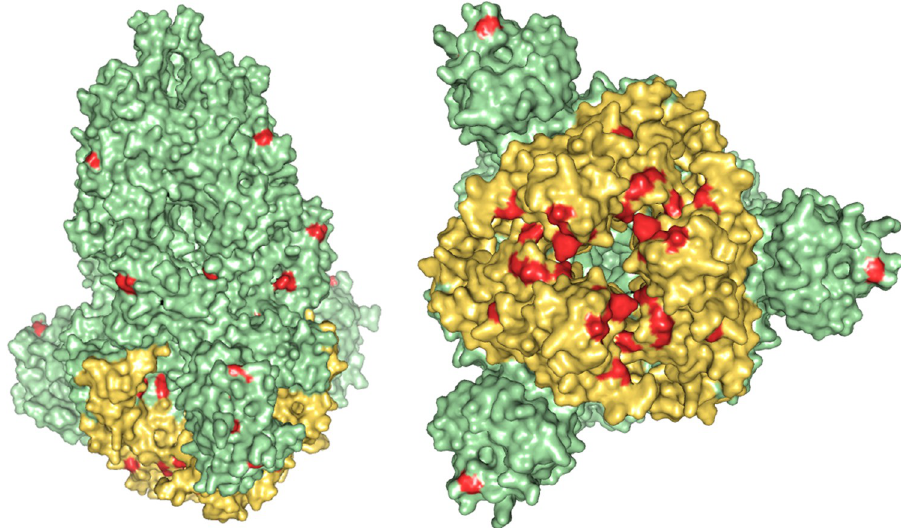
Fig 1. Three-dimensional structure of the Omicron variant spike protein. RBD region is colored in golden and mutations are highlighted in red. Nearly half of the mutations occur in the receptor-binding domain.